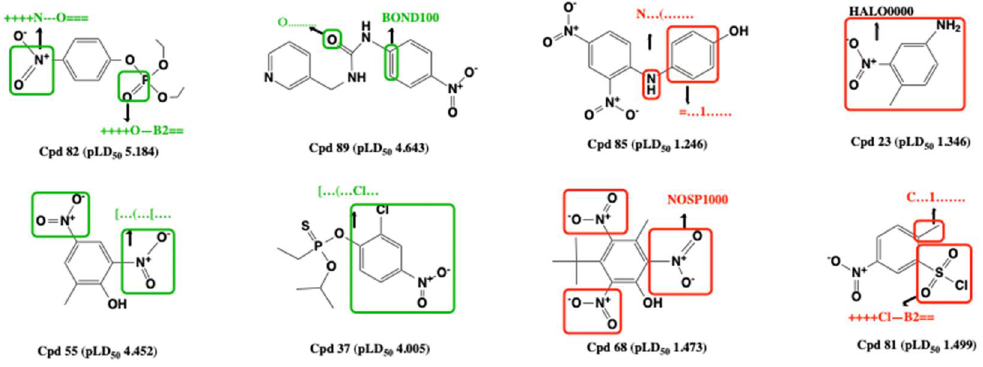
Figure 1. Molecular fragments for toxicity promotors (green) and inhibitors